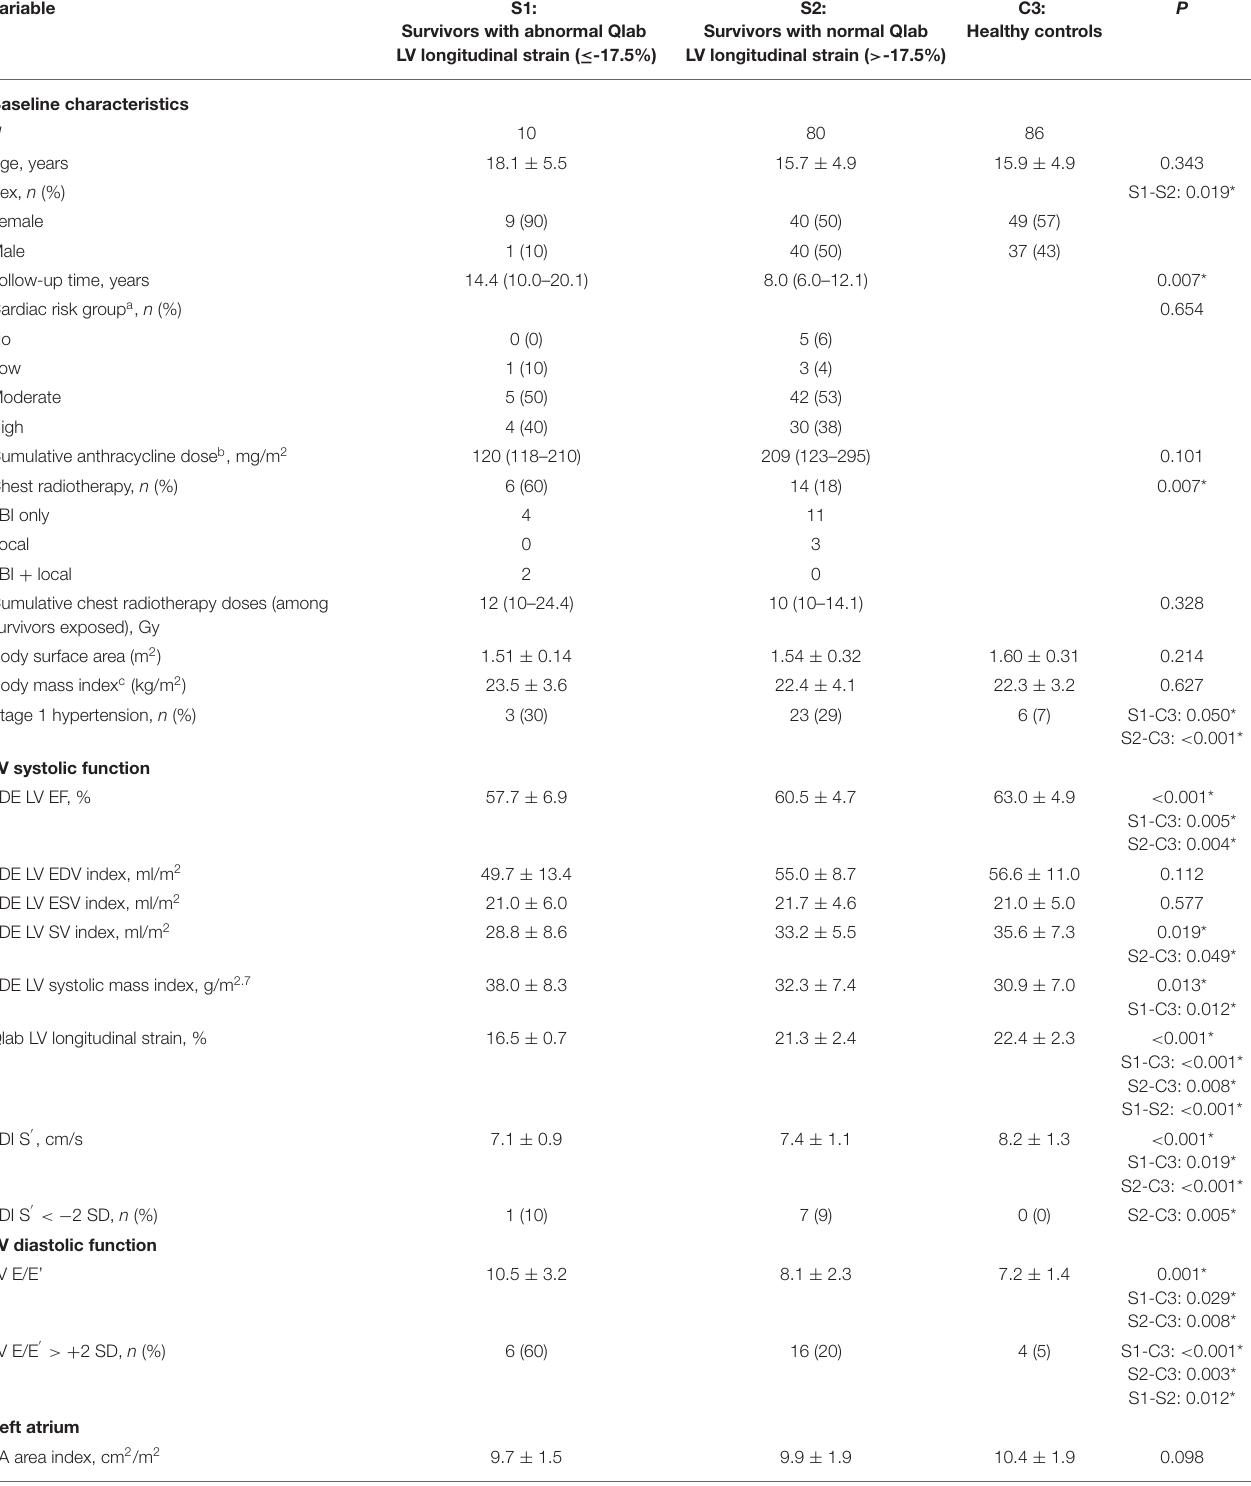
TABLE 2 | Baseline characteristics and echocardiographic parameters of the study subjects according to group.